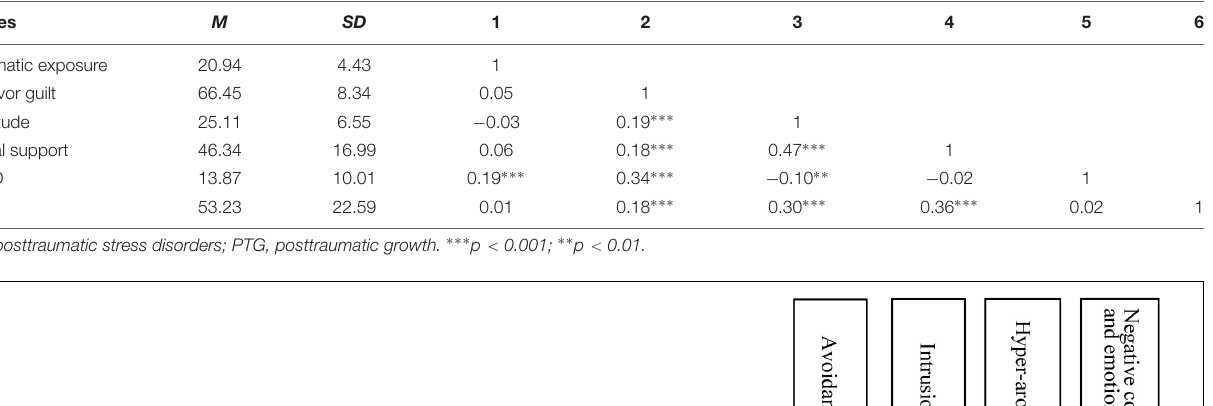
a direct positive effect on PTSD and PTG, which was consistent with previous studies (Owens et al., 2008; Dekel et al.,